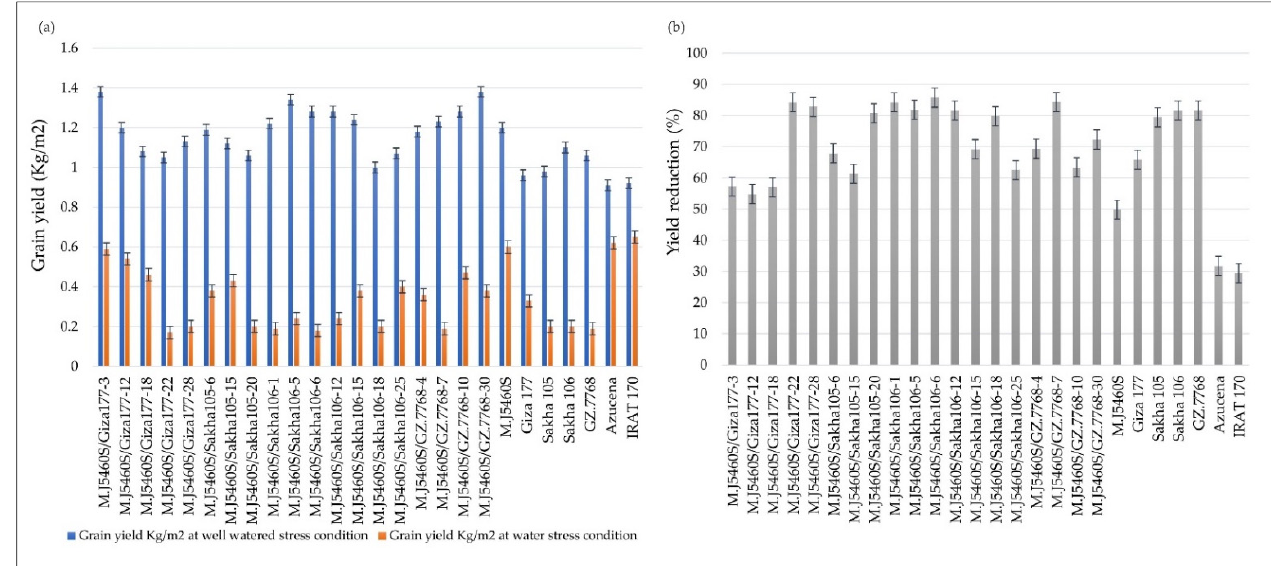
Figure 1. The performance of the newly developed lines. ( a ) GY (kg/m 2 ) under well-watered as compared to water-stress conditions and ( b ) yield reduction due to the stress condition.